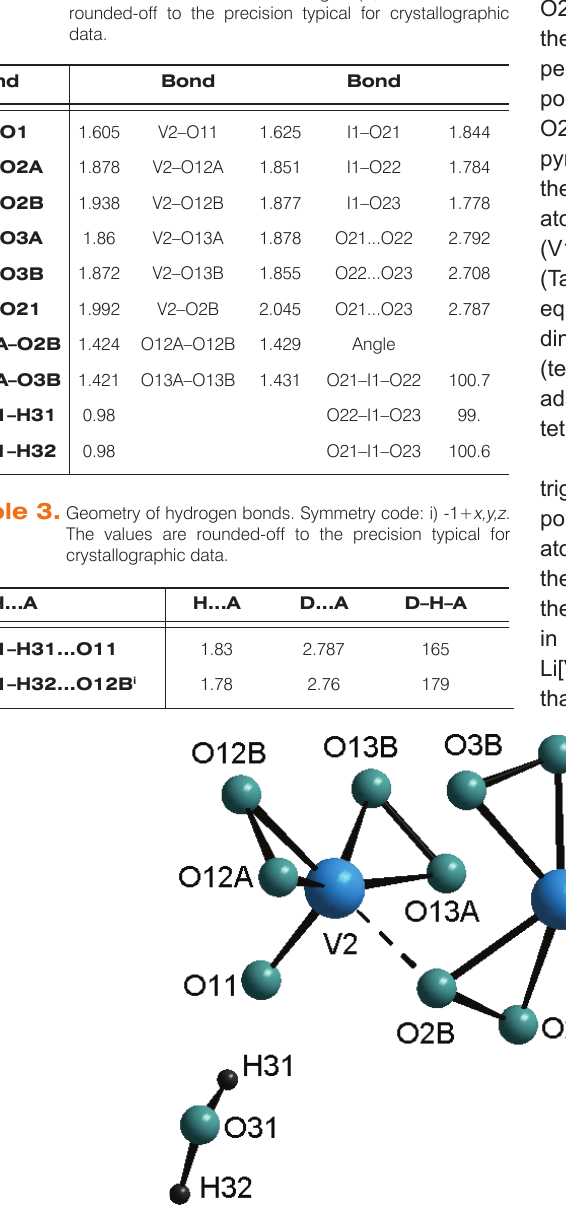
Figure 3. Atom numbering of scheme of [V are not displayed. The V1...V2 separation is 3.081